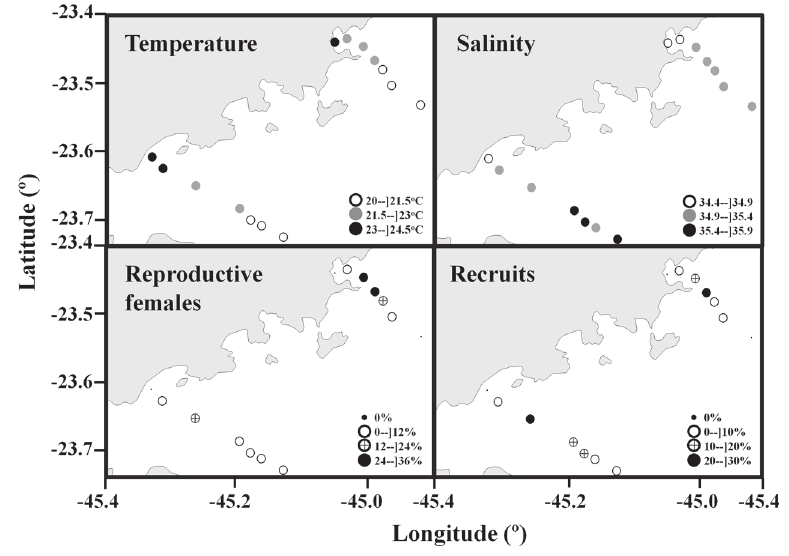
Figure 7 - Spatial variation of the abiotic factors (temperature and salinity) and percentage of Artemesia longinaris (N) in each demographic groups (reproductive females and recruits), at each region sampled, from July 2001 to June